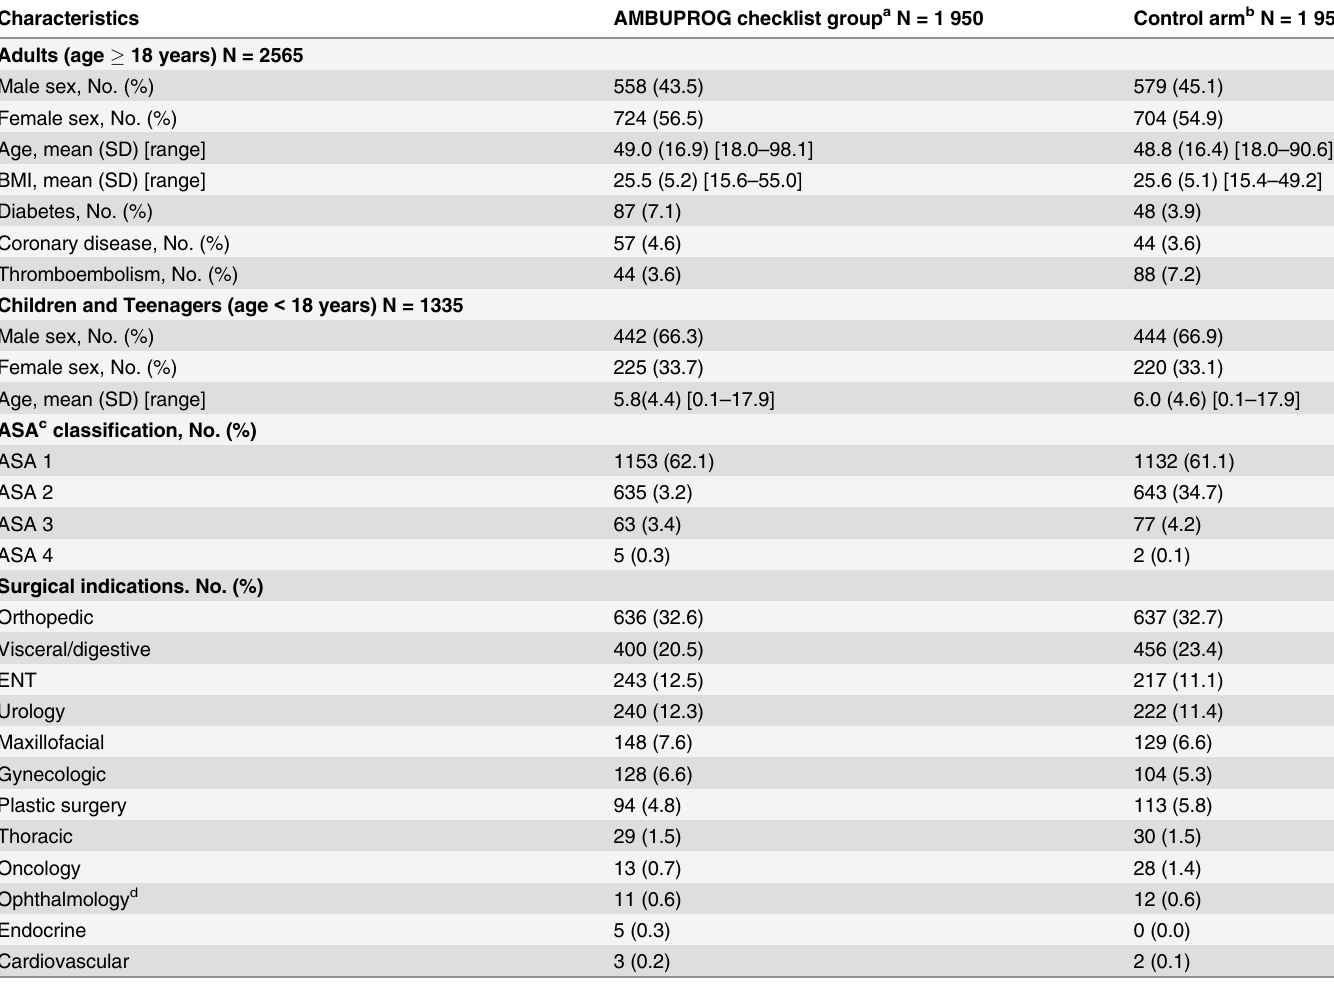
Table 2. Baseline characteristics of patients in the AMBUPROG